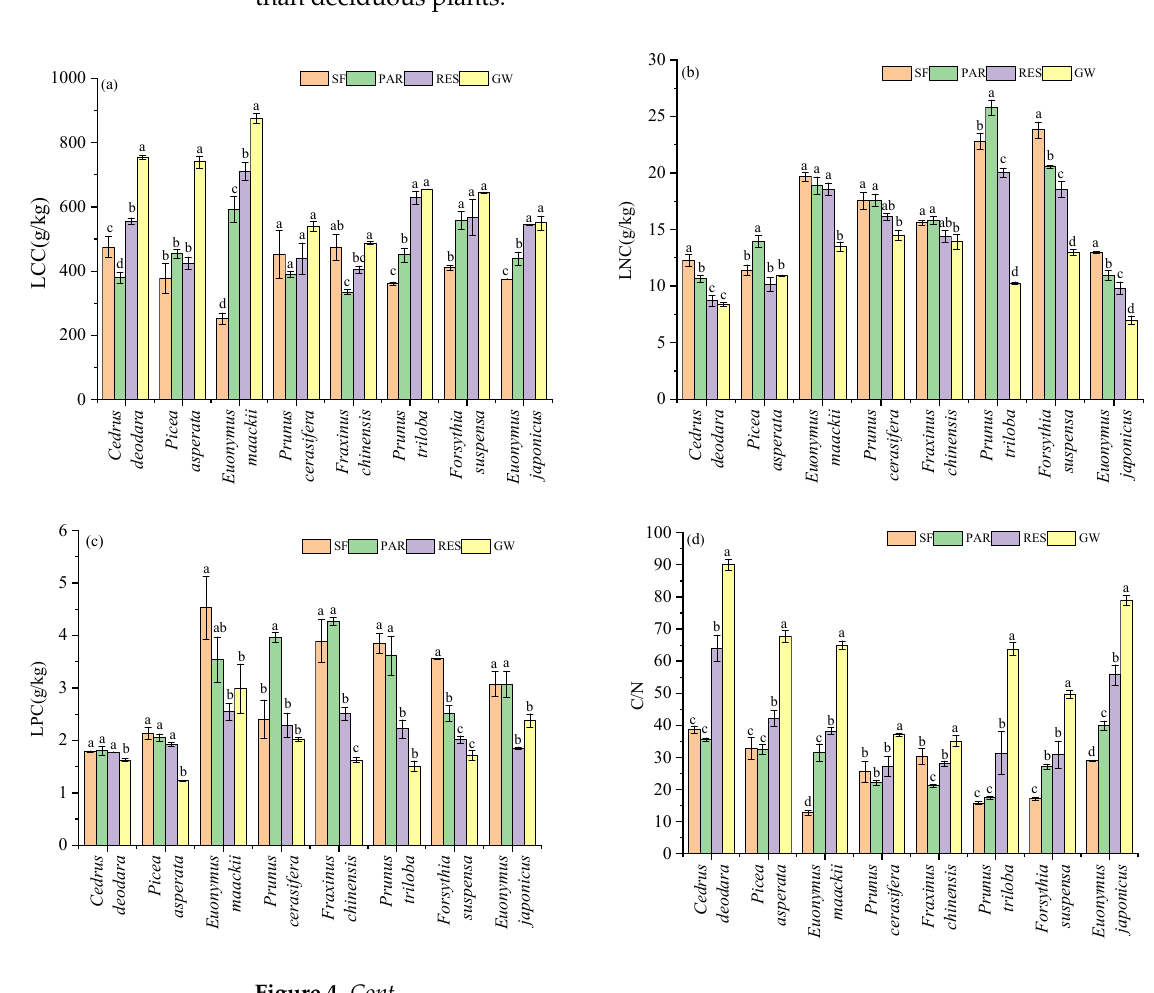
Figure 4. Characteristics of the leaf nutrient traits of eight plants in four urban green space environ- ments. SF = sport field; PAR = park; RES = residential green space; GW = greenway. Different letters above the bars indicate significant differences among four urban green spaces: ( a ) leaf carbon con- tent (LCC); ( b ) leaf nitrogen content (LNC); ( c ) leaf phosphorus content (LPC); ( d ) leaf carbon/nitro- gen ratio(C/N); ( e ) leaf carbon/phosphorus ratio (C/P); ( f ) leaf nitrogen/phosphorus